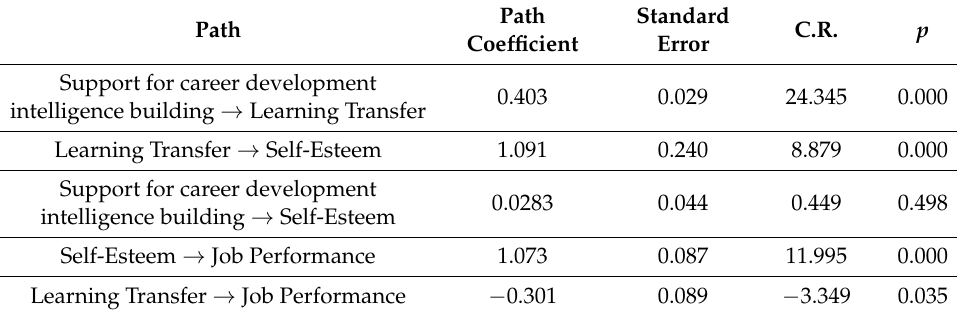
Table 5. The path estimates of full mediation model.